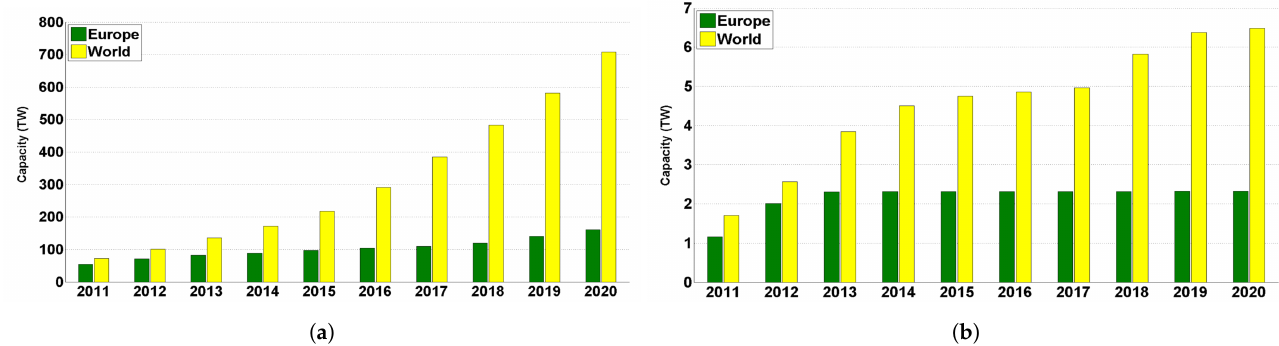
Figure 10. Global cumulative installed capacity of solar power in the last ten years in the Europe and world [29]: ( a ) PV capacity. ( b ) CSP